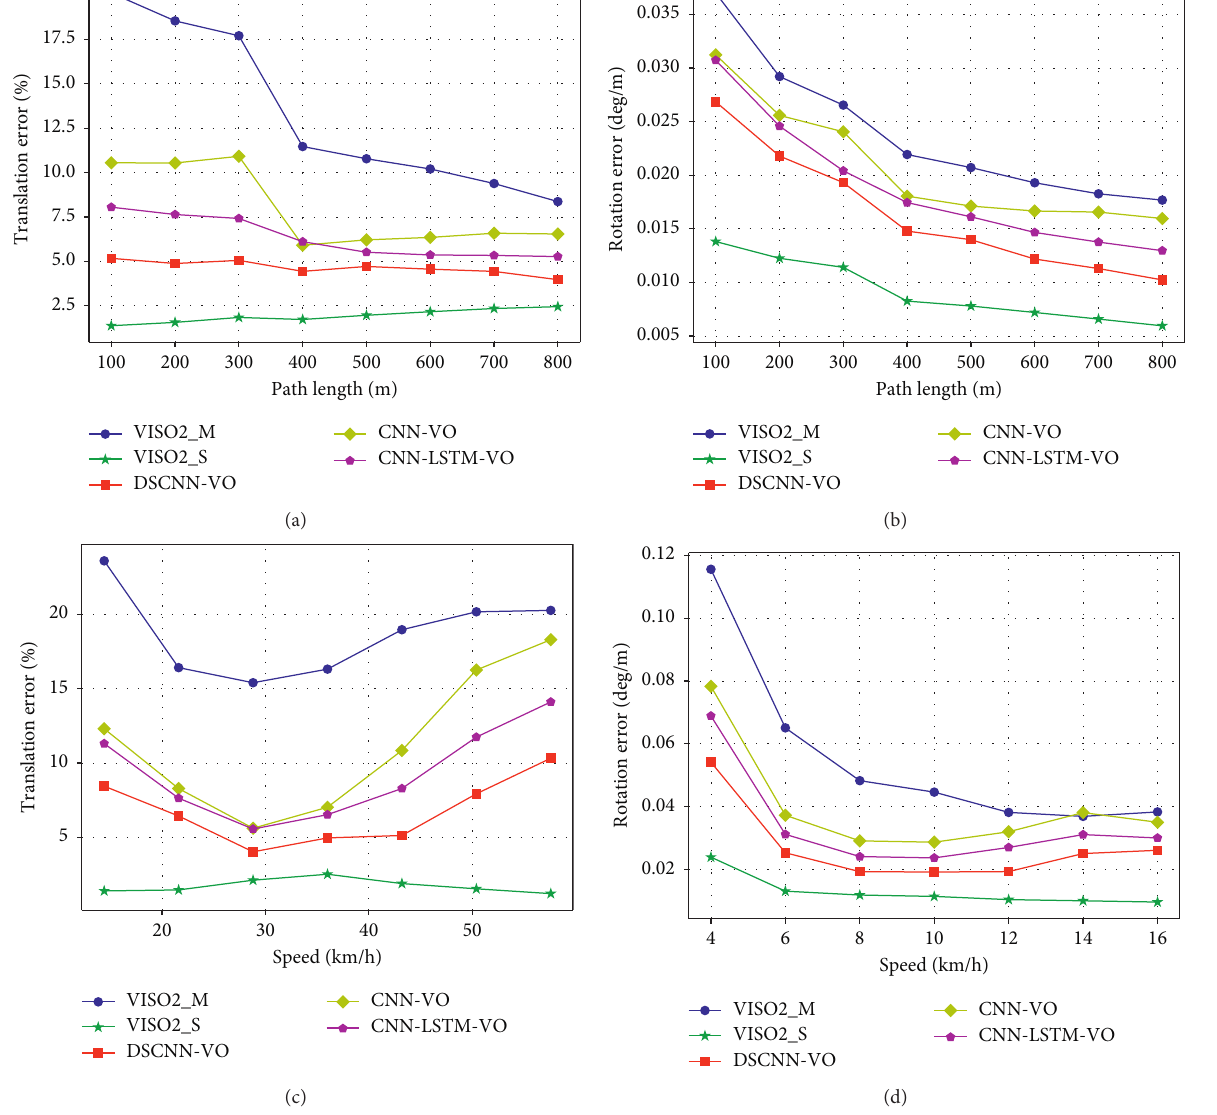
Figure 8: Average errors tested on translation and rotation against different path lengths and speeds. The DSCNN-VO, CNN-VO, and CNN-LSTM-VO were trained and tested in the same conditions. (a) Translation error against path length. (b) Rotation error against path length. (c) Translation error against speed. (d) Rotation error against